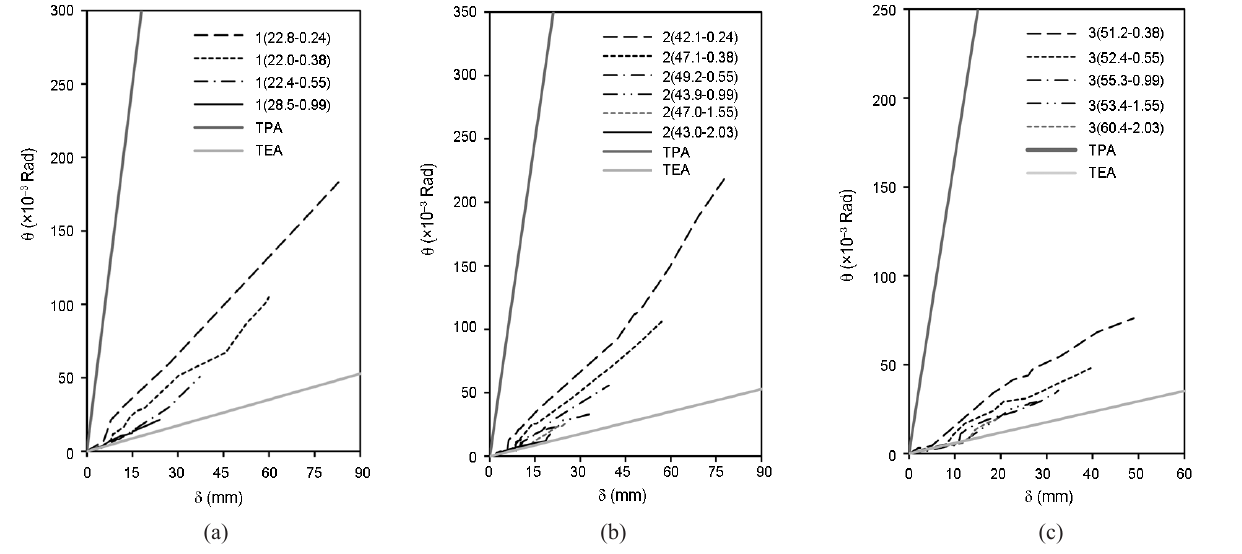
Fig. 4. q – δ Curves: (a) Series 1; (b) Series 2; (c) Series